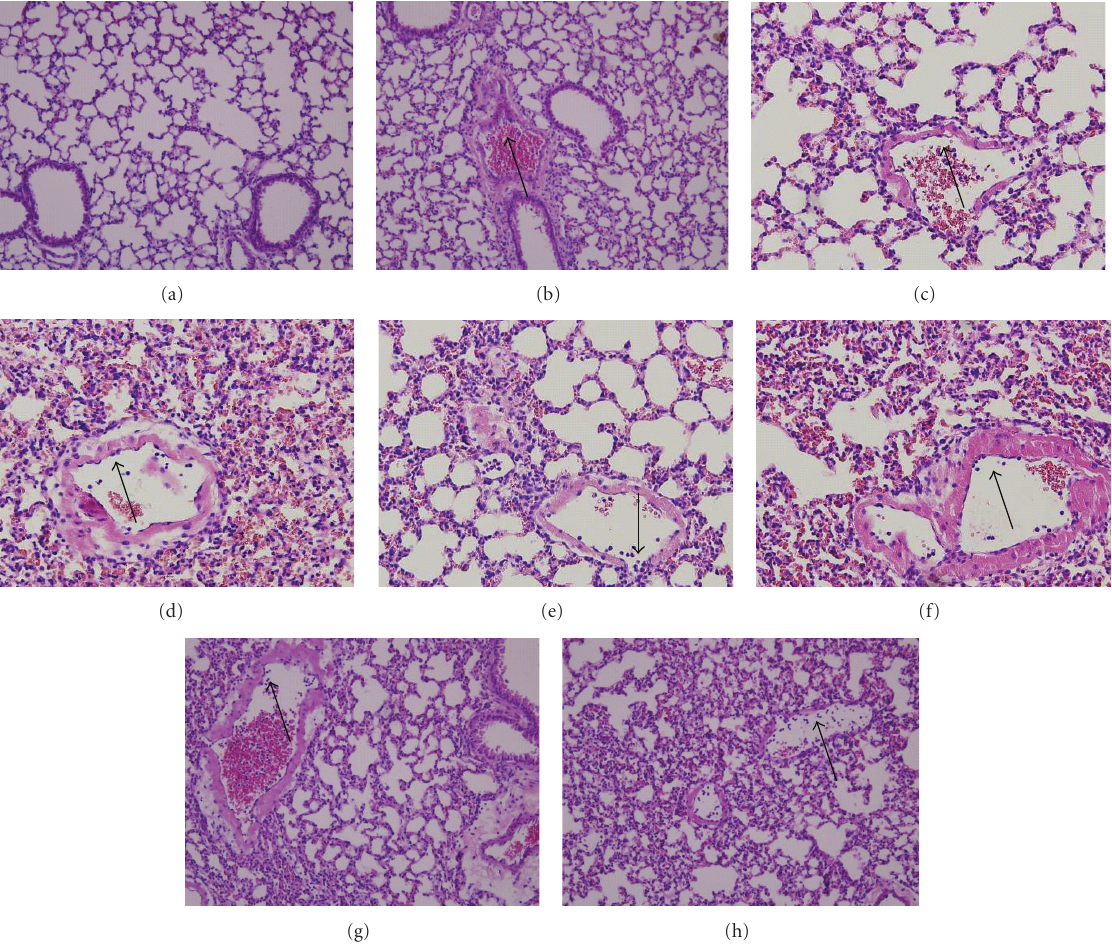
Figure 2: Histologic sections of hematoxylin-and-eosin-stained mice lungs at 100x magnification after mechanical ventilated using low ventilation tidal (V T ) (7.5mL/kg) or high V T (15 mL/kg). Ventilated animals receiving 0.5 mg/kg, 2.0mg/kg or 4.5 mg/kg MHC-I antibody ( n = 6 per group). (a) low V T control, (b) high V T control, (c) 0.5 mg/kg low V T , (d) 0.5 mg/kg high V T , (e) 2.0 mg/kg low V T , (f) 2.0mg/kg high V T , (g) 4.5 mg/kg low V T , (h) 4.5 mg/kg high V T . Neutrophils sequestrated in the vasculature (arrow; (a)–(h)). Increased pulmonary edema and neutrophil extravasation ((d),